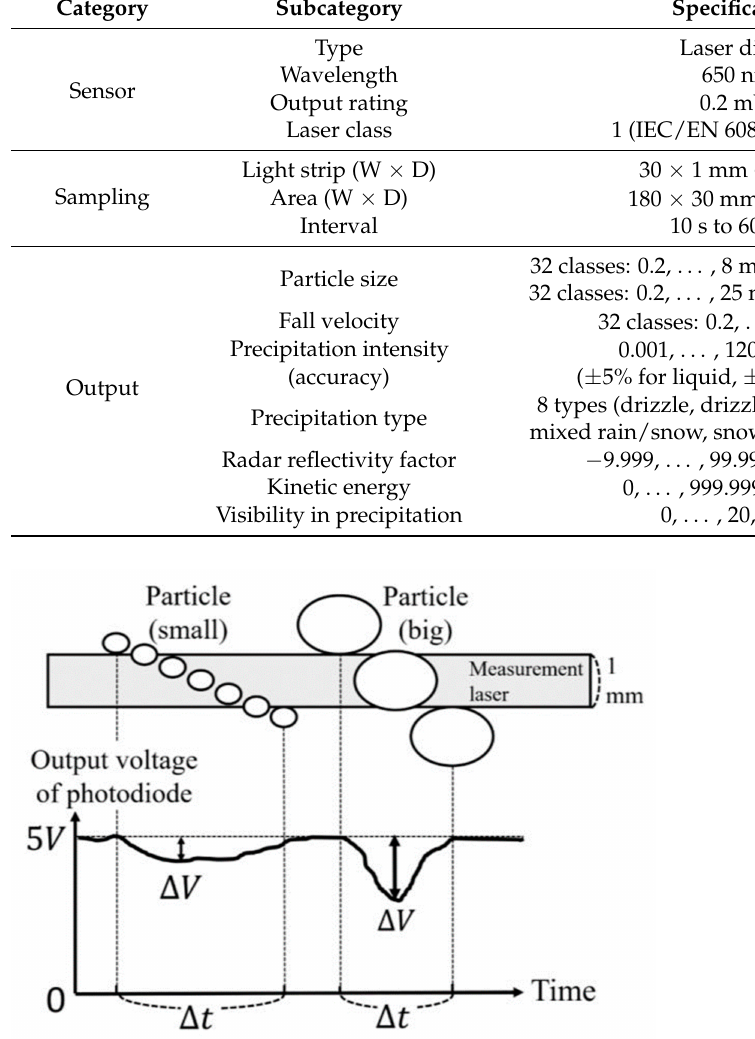
Figure 1. Schematic diagram illustrating ash particle diameter and fall velocity measurements by Parsivel 2 (Löffler-Mang and Joss, 2000). As a particle passes through the measurement laser beam sheet, voltage reduction ∆ V is generated during time interval ∆ t at the light-receiving device. The particle diameter is estimated from ∆ V , and fall velocity is estimated from ∆ t